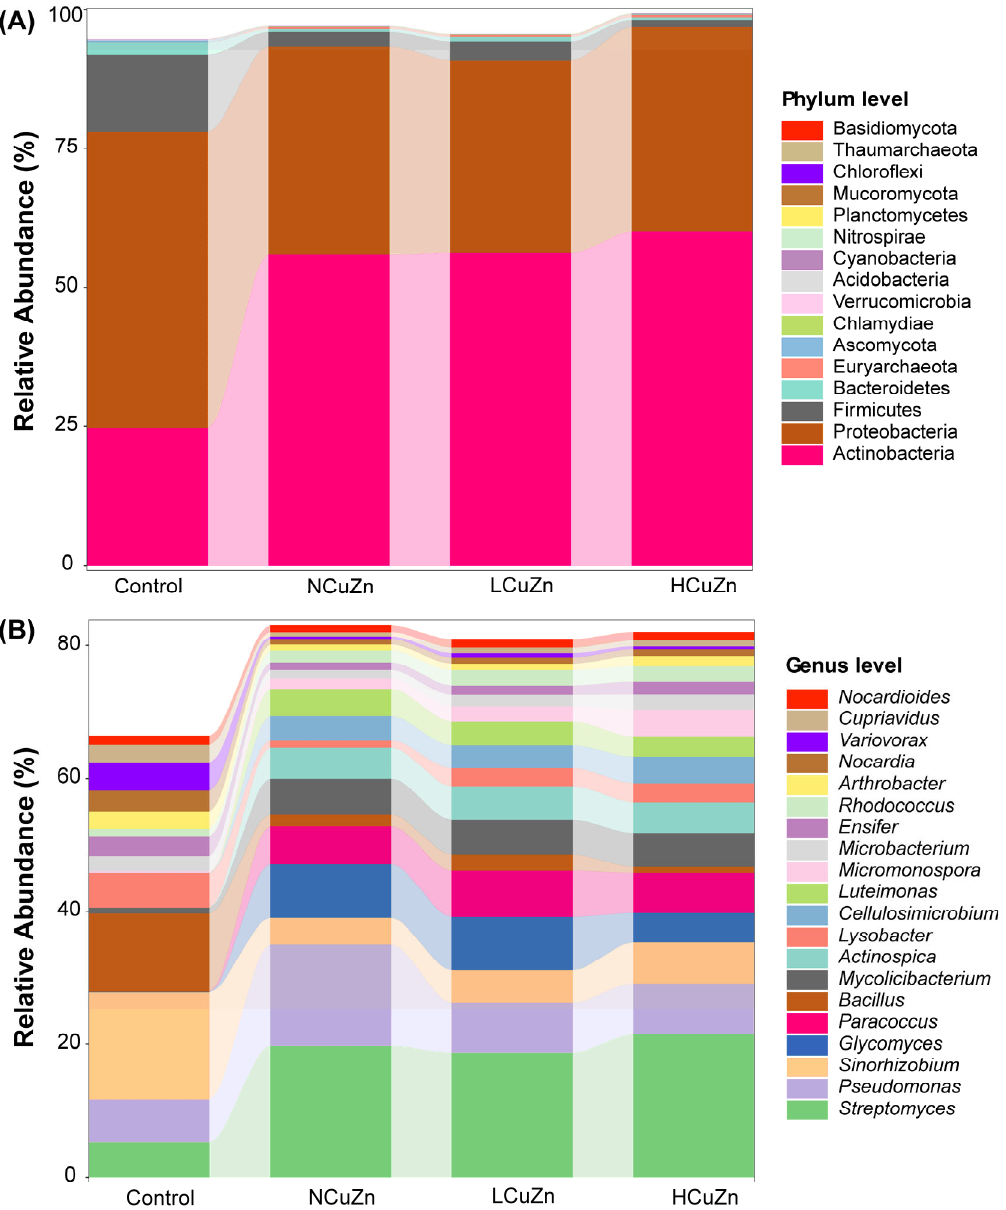
Figure 2. Bacterial community composition in different treatments. ( A ) Phylum level, ( B ) genus level.